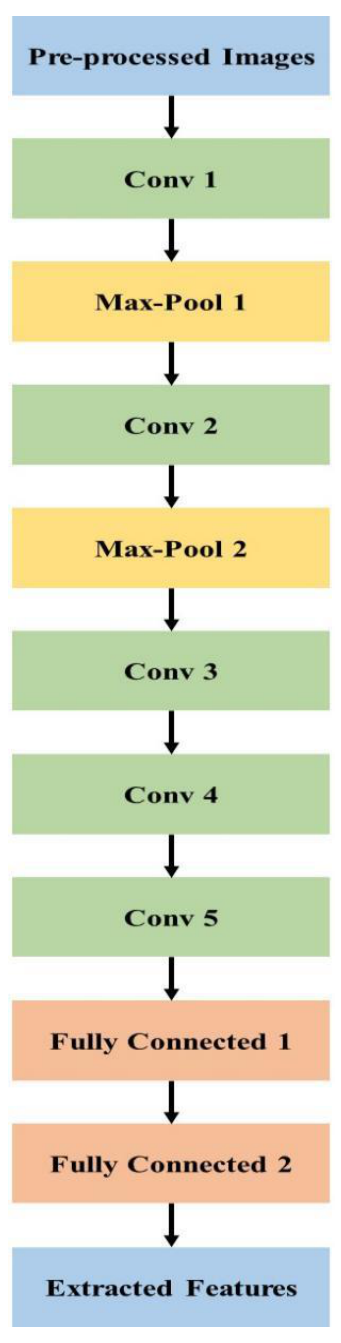
Figure 3. AlexNet architecture for feature extraction.